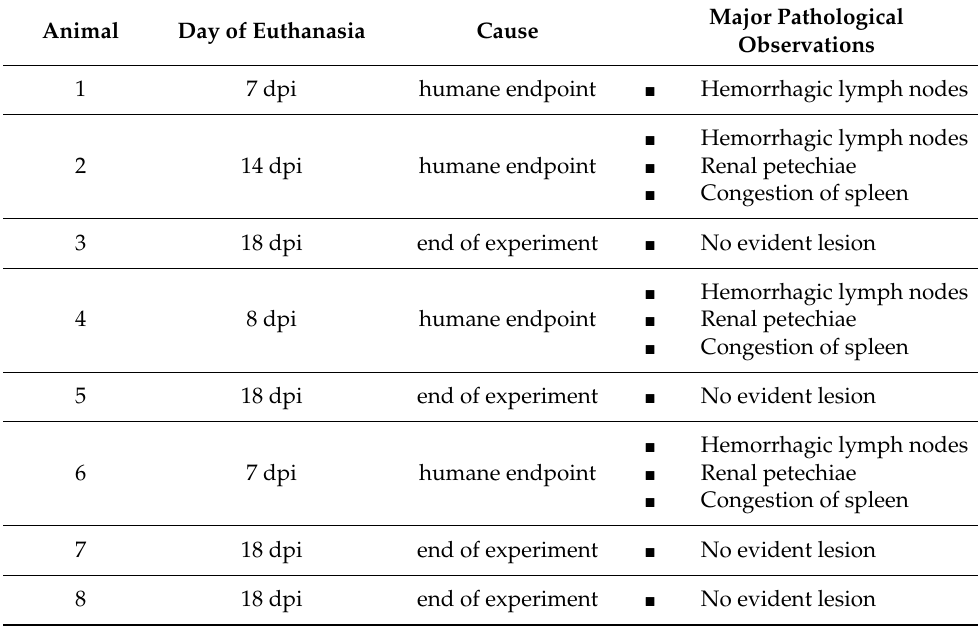
Table 1. Overview of pathological findings per animal from trial A.